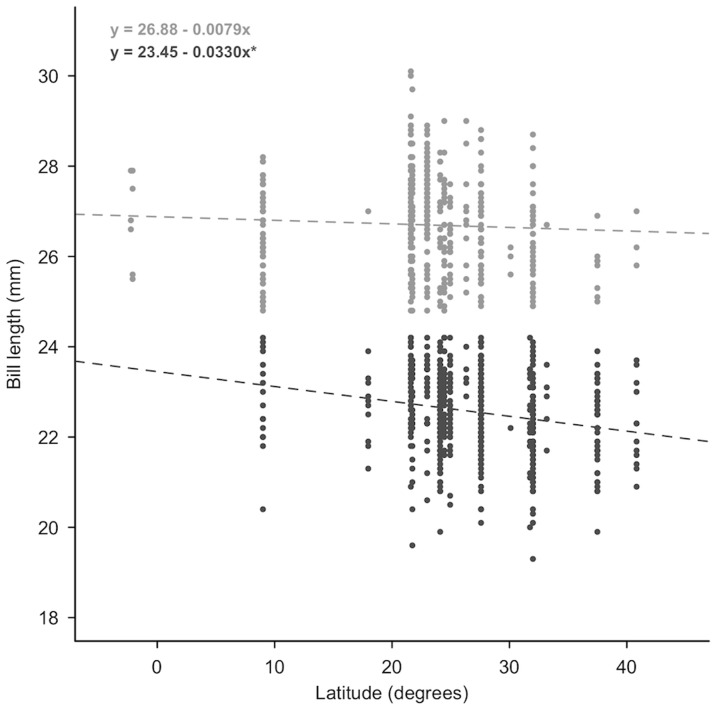
Relationship of bill length with wintering latitude by sex.The relationship of bill length with latitude for male (dark grey) and female (light grey) western sandpipers sampled at wintering sites between November 2008 and February 2009 (n = 1019). Fitted lines were calculated from linear regression parameter estimates, and the asterisk (*) denotes a significant relationship.